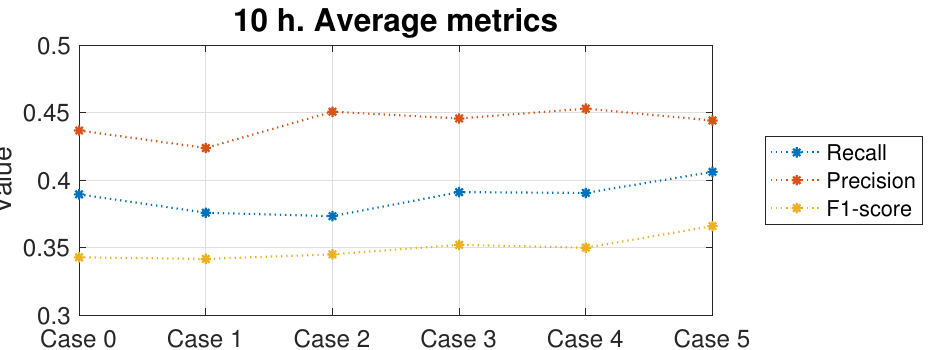
Figure 20. Average metrics of all the classification methods considering the 6 different scenarios assessed, for a time prediction horizon of +10